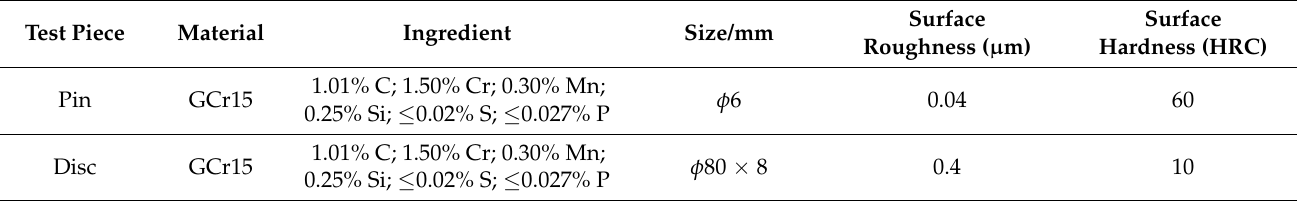
Table 3. Parameters of the pin and